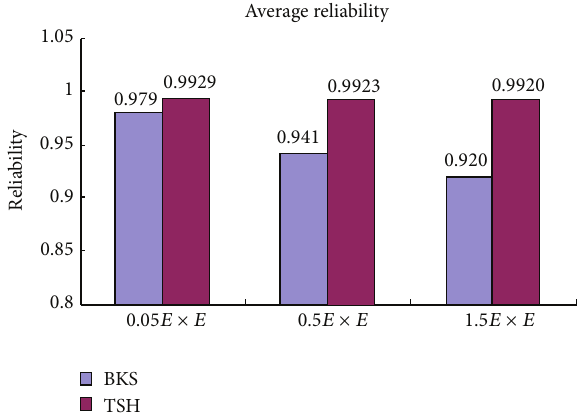
Figure 5: Average reliabilities of solutions under different uncer- tainty